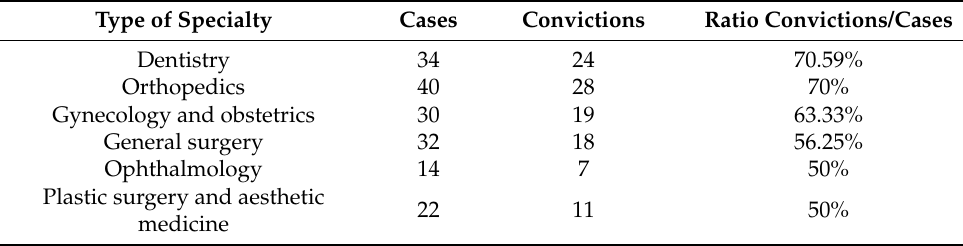
Table 1. Most involved specialties and risk of recognizing liability in court.